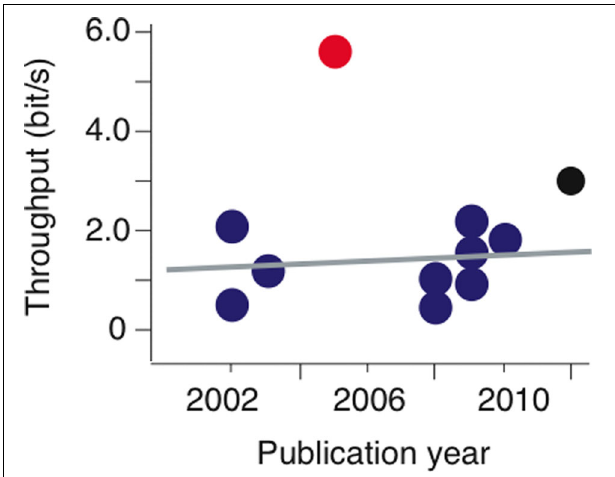
FIGURE 2 | Information transfer rates or throughput estimated for center-out reaching task (blue and black circles) and for “GO” cue task (red circle) in BMI papers. Most data were taken from supplemental material of Gilja et al. (2012) while the “GO” cue data are for Santhanam et al. (2006) study. The line represents a linear fit for all blue data points; there was no significant increase in information transfer rates in this time